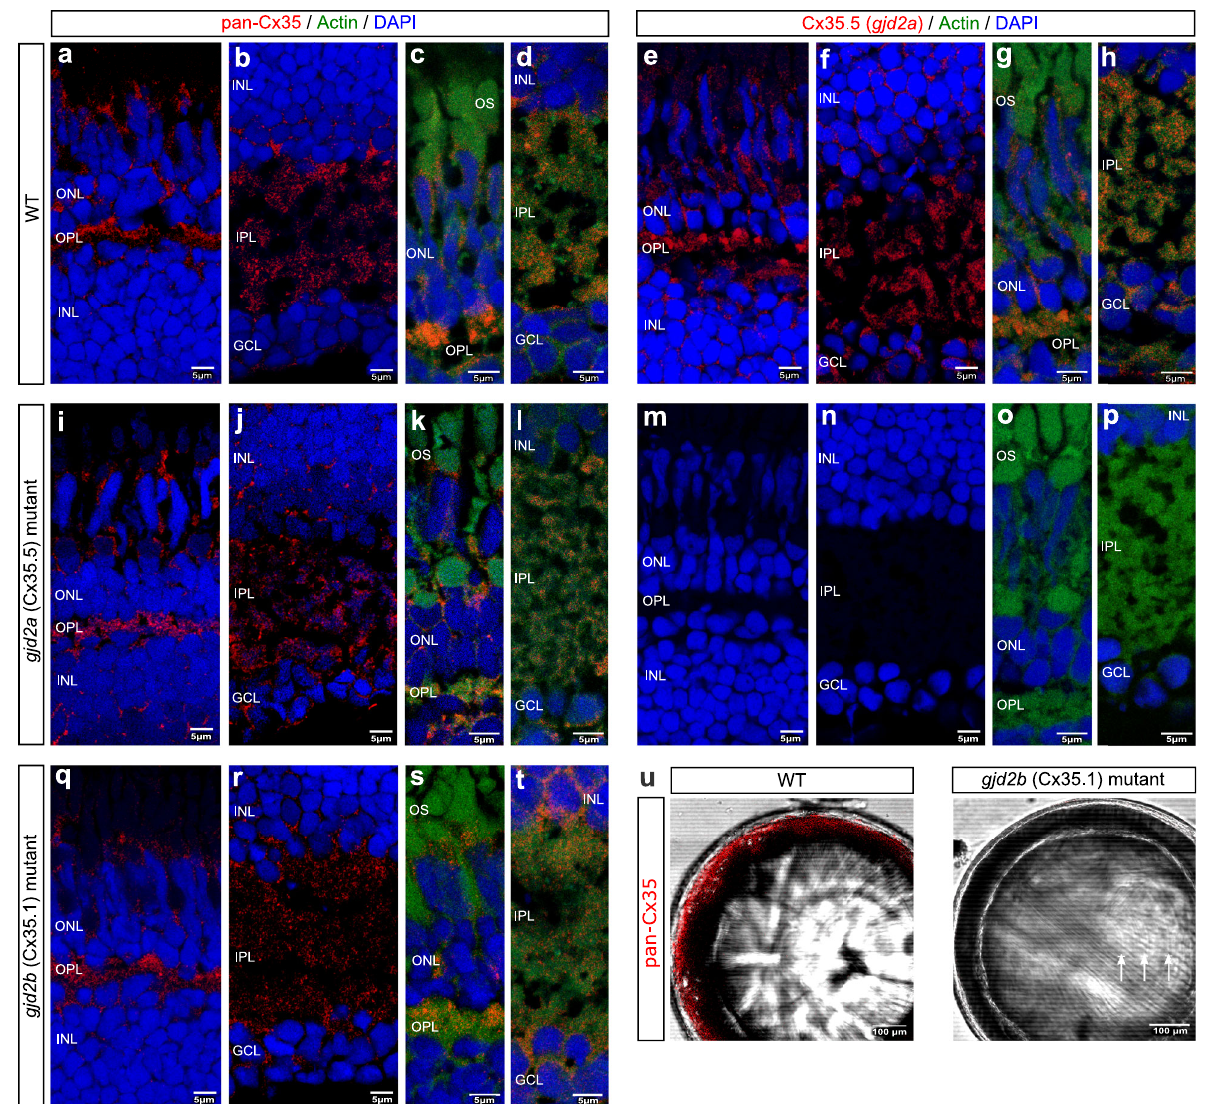
Fig. 6 Ocular expression of Cx35.5 ( gjd2a ) and Cx35.1 ( gjd2b ). Immunostaining showing the topographic distribution of Cx35.5 ( gjd2a ) and Cx35.1 ( gjd2b ) throughout the 2.5 mpf zebra fi sh retina ( a ) – ( t ) and Cx35.1 ( gjd2b ) throughout the 6 mpf zebra fi sh lens ( u ). The retinal sections in the left and right column are stained for respectively anti-pan-Cx35 and anti-Cx35.5 ( gjd2a ) (both in red) and each row indicates the genotype. DAPI (blue) and anti-actin (green) are used for orientation. The staining in the WT retina for anti-pan-Cx35 ( a ) – ( d ) and the speci fi c anti-Cx35.5 ( e ) – ( h ) reveal generally overlapping patterns of localization in the IPL, OPL, and photoreceptor layer. In the gjd2a (Cx35.5) mutants the anti-pan-Cx35 staining ( i ) – ( l ) supports that this antibody recognizes both Cx35.5 ( gjd2a ) and Cx35.1 ( gjd2b ) and reveals the localization of Cx35.1 ( gjd2b ). The absence of staining in the gjd2a (Cx35.5) mutants with the anti-Cx35.5 antibody ( m ) – ( p ) support the speci fi city of the antibody and con fi rms the Cx35.5 ( gjd2a ) localization presented in ( e ) – ( h ). The presence of staining in the gjd2b (Cx35.1) mutants with the anti-pan-Cx35 antibody ( q ) – ( t ) support that this antibody recognizes both Cx35.5 ( gjd2a ) and Cx35.1 ( gjd2b ) and supports the localization of Cx35.5 ( gjd2a ). u Anti-pan-Cx35 immunostaining in isolated 6mpf WT and Cx35.1 ( gjd2b ) mutant lenses. A modest lenticular appearance at the outer cortical layer can be observed in WT control while absent in gjd2b (Cx35.1) null mutants. The gjd2b (Cx35.1) null mutant lens shows a nuclear ring structure (arrows). Scale bars: 5 µ m ( a ) – ( t ), 100 µ m ( u ). IPL inner plexiform layer, OPL outer plexiform